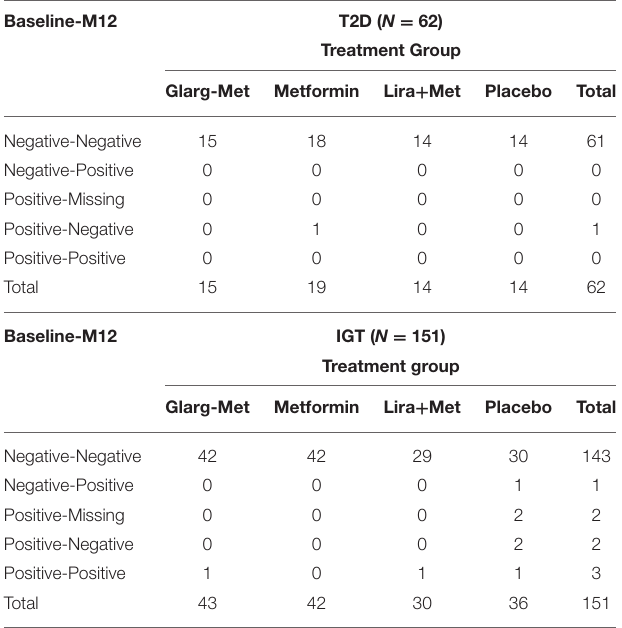
TABLE 3 | Categories of GADA status change by diabetes status and treatment